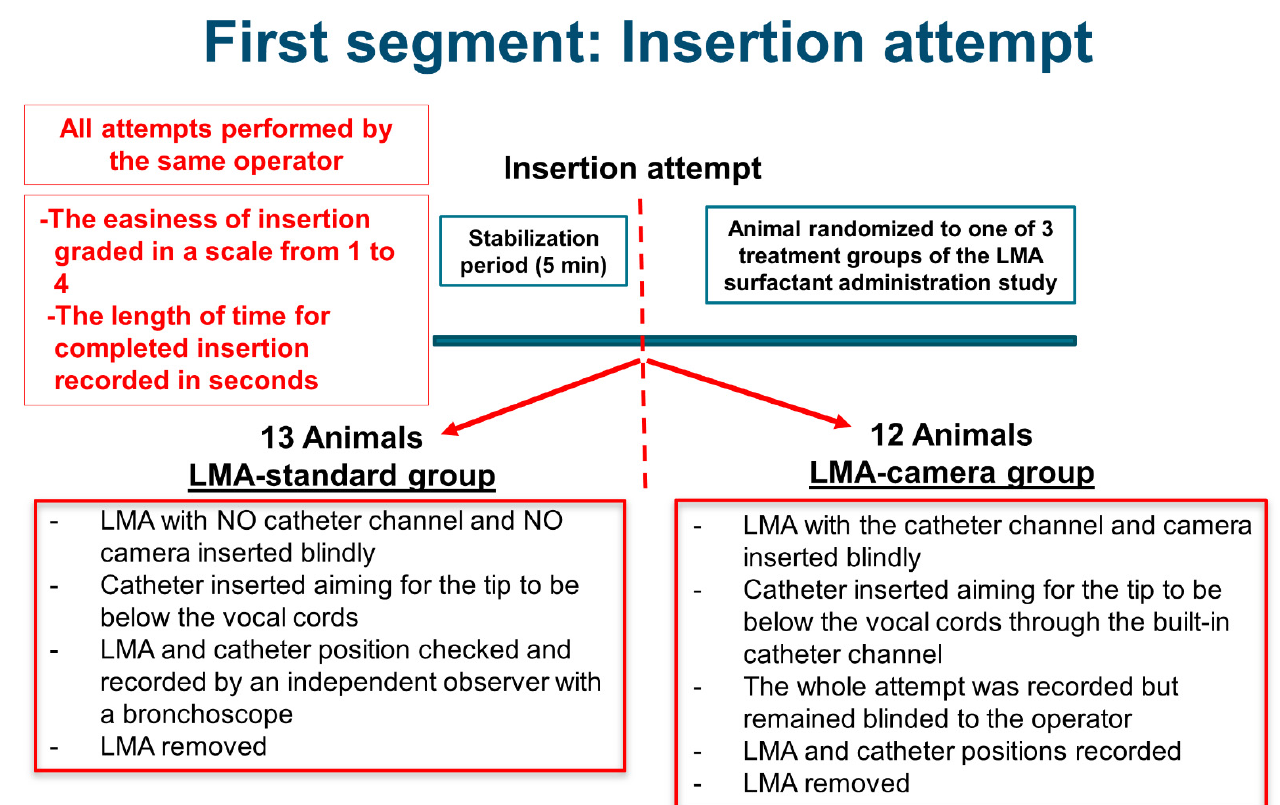
Figure 2. Summary of the first segment (Insertion attempt) of the experimental study protocol. LMA, laryngeal mask airway.